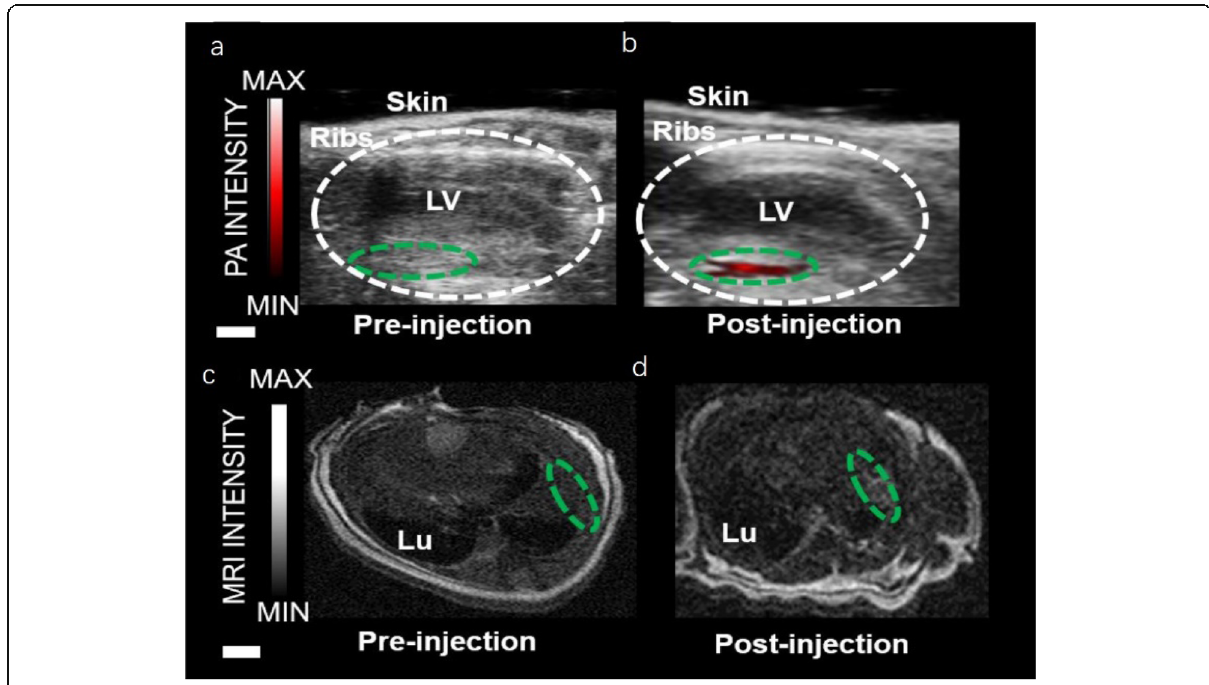
Fig. 11 PAI and MRI of Gd (III)-SMNP implanted into mouse hearts